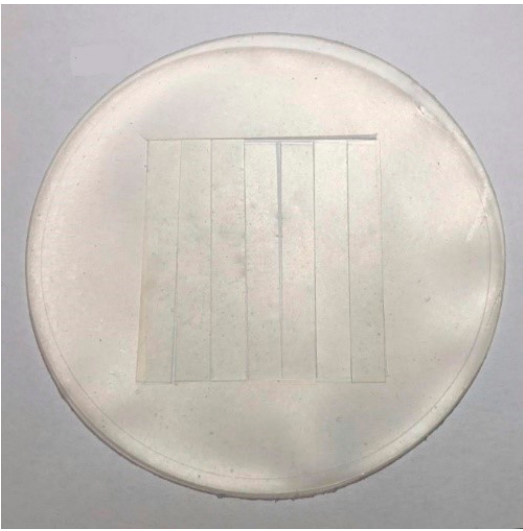
Figure 1. 50 wt.% PA6-CNF casted nanocomposite